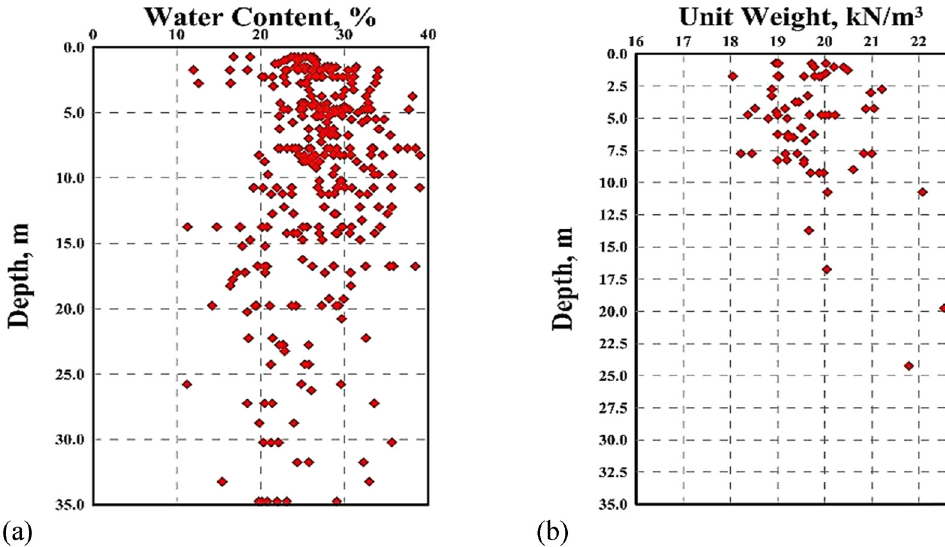
Figure 7: Variance of the water content and the unit weight with depth: ( a ) water content ( % ) and ( b ) unit weight ( kN/m 3 )